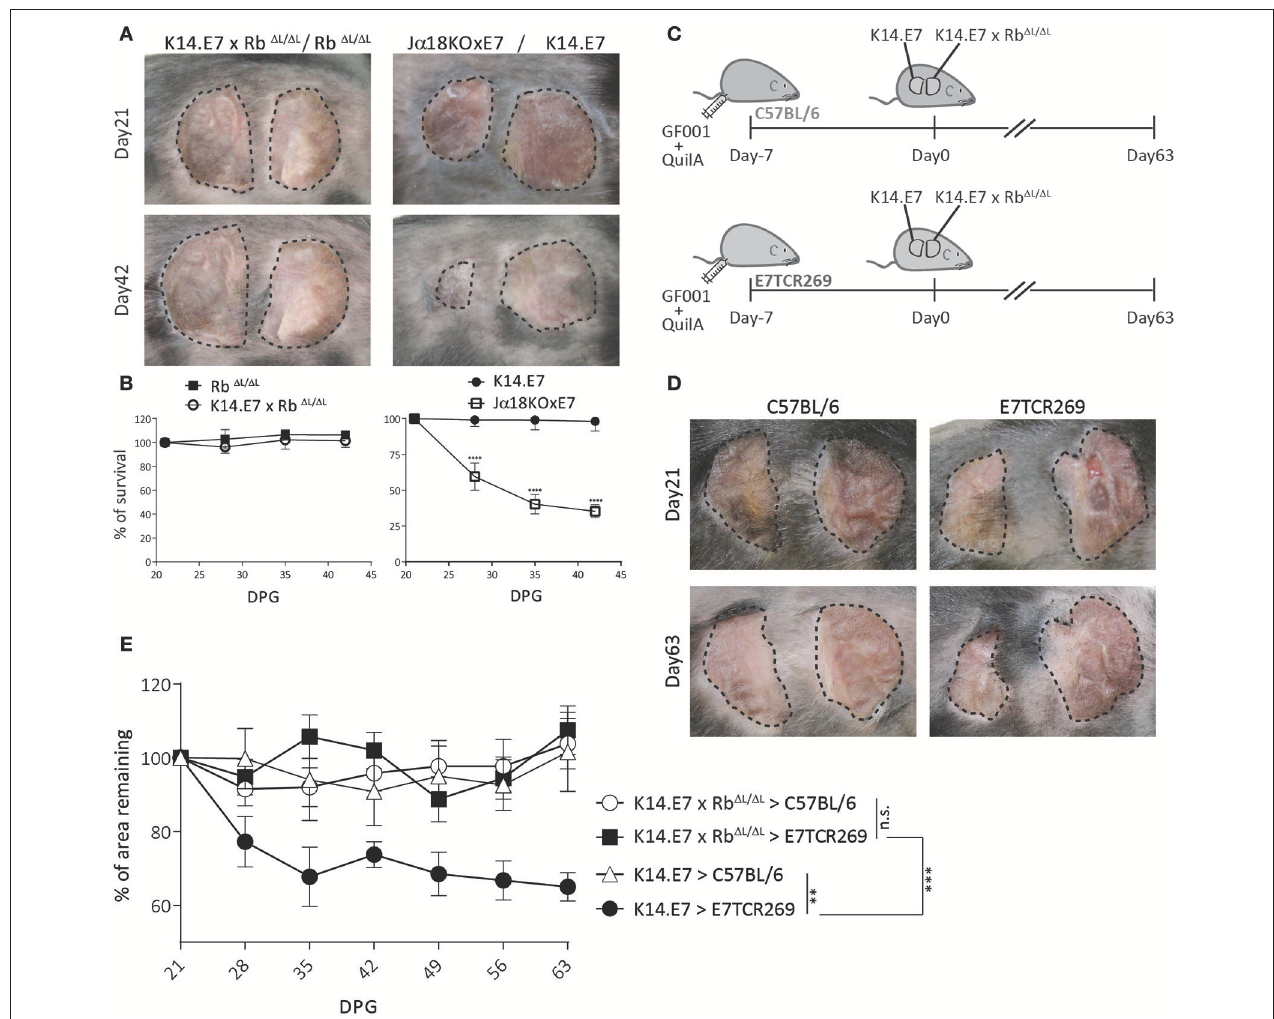
FIGURE 2 | K14.E7xRb 1 L /1 L skin grafts are not rejected from immunocompetent syngeneic recipients. (A) Grafts of donor ear skin, as shown, onto C57BL/6 recipients at 21 and 42-days post grafting. (B) Area remaining of graft at the indicated time points (DPG). (C) C57BL/6 and E7TCR269 recipients were immunized with GF001 (50 µ g) and QuilA (5 µ g) subcutaneously 7 days before grafting. (D) Representative photos of graft-bearing recipients on day 21 and day 63. K14.E7 skin (left) and K14.E7xRb 1 L /1 L skin (right). (E) Area remaining of graft at the indicated time points, compared to the graft on day 21. DPG, day post grafting. Analyses were done using one-way ANOVA, with Bonferroni’s multiple comparison tests. Error bars showing mean ± SEM with n ≥ 3. Result significance was shown, where ** p < 0.01, *** p < 0.001, and **** p < 0.0001.